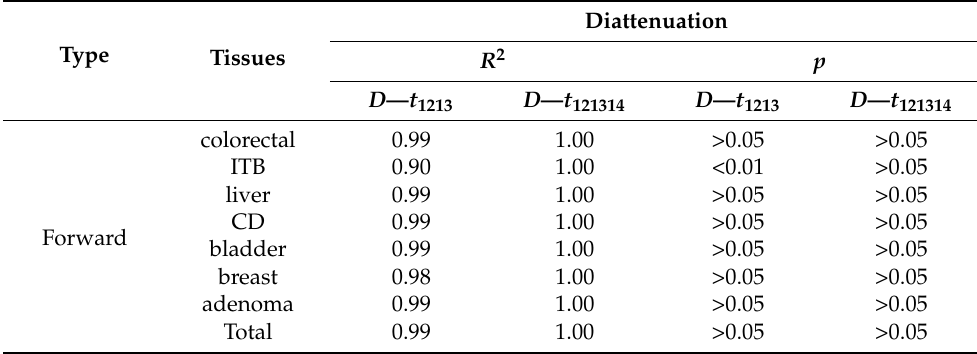
Table 2. Correlation and statistical analysis comparison results between forward measured MMT and MMPD diattenuation parameters for each kind of thin tissue